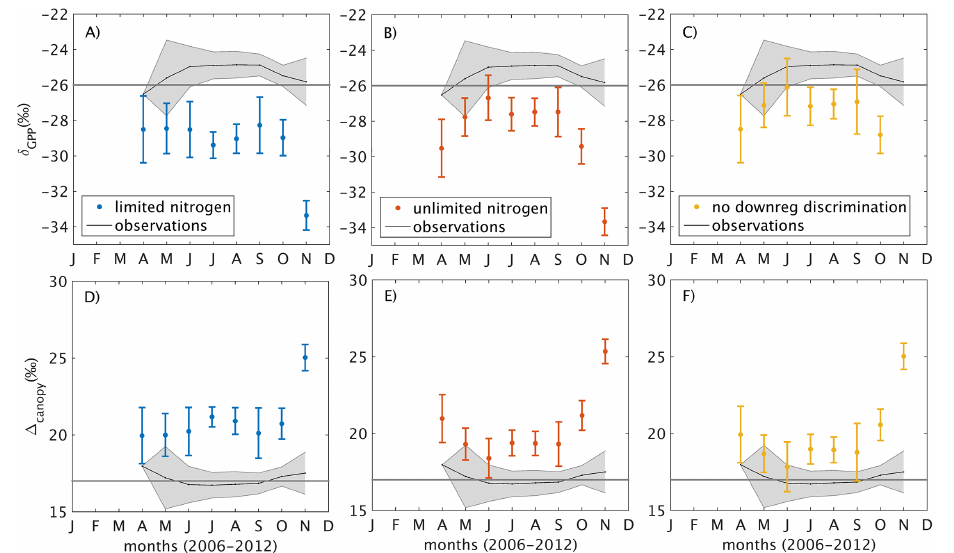
Figure 8. The seasonal pattern of photosynthetic discrimination as shown through δ GPP (a, b, c) and (cid:49) canopy (d, e, f) . Uncertainty bars represent 95% confidence bounds of simulated monthly average values from 2006 to 2012. Gray-shaded observation bounds represent 95% confidence intervals of observed monthly average values based upon isotopic mixing model using Reichstein et al. (2005) partitioning of net ecosystem exchange flux described by Bowling et al. (2014). The horizontal lines at δ 13 C of − 26‰ (a, b, c) and 17‰ (d, e, f) are included for reference.